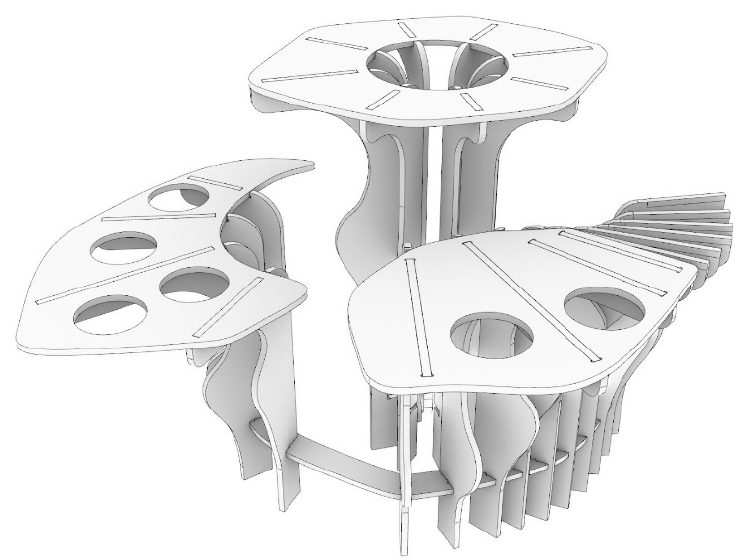
Figure 7. Revised 3D model.